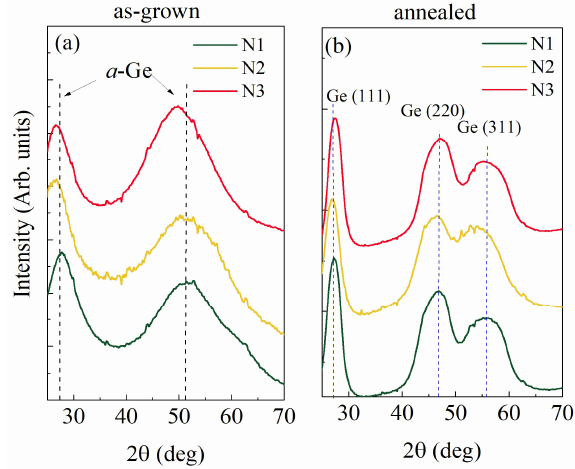
Figure 3. Grazing incidence wide-angle X-ray scattering (GIWAXS) of the ( a ) as-grown and ( b ) annealed films. The position of the amorphous Ge (a-Ge) and crystalline Ge (c-Ge) peaks are denoted by dashed lines.